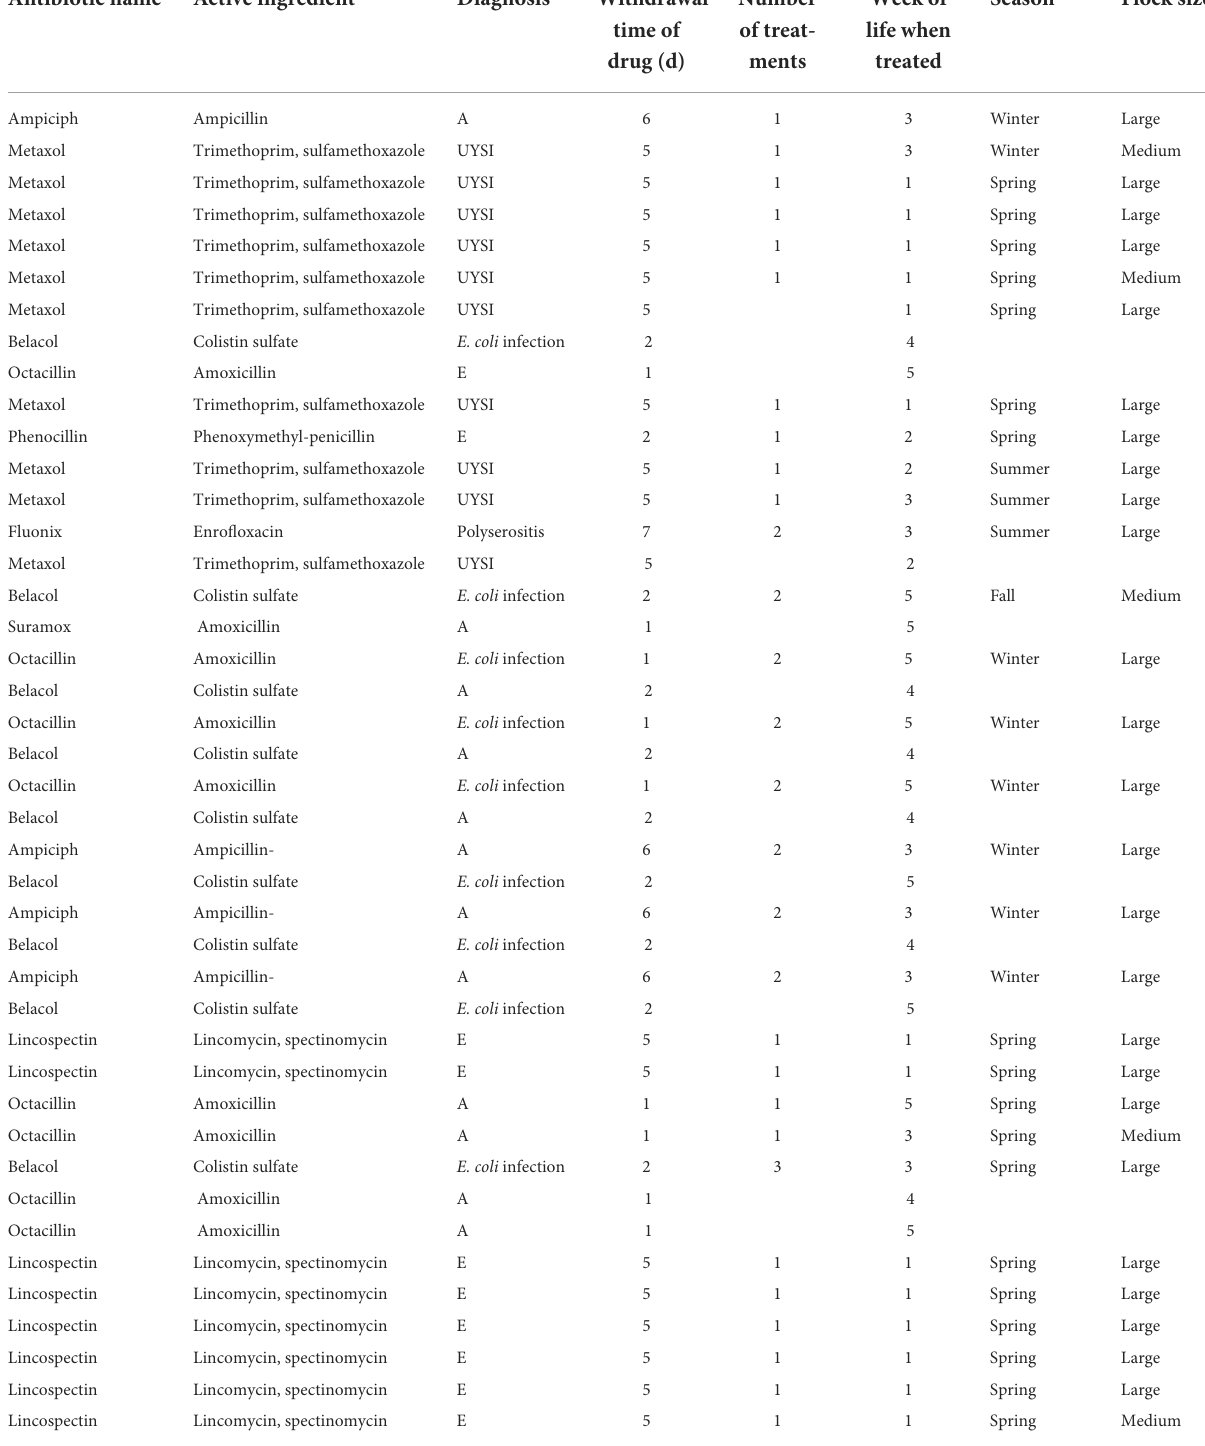
TABLE 6 Antibiotic treatments ( n = 30): name, active ingredient, diagnosis, withdrawal time of drug (days), number of treatments, week of life when treated, season, and size of the treated